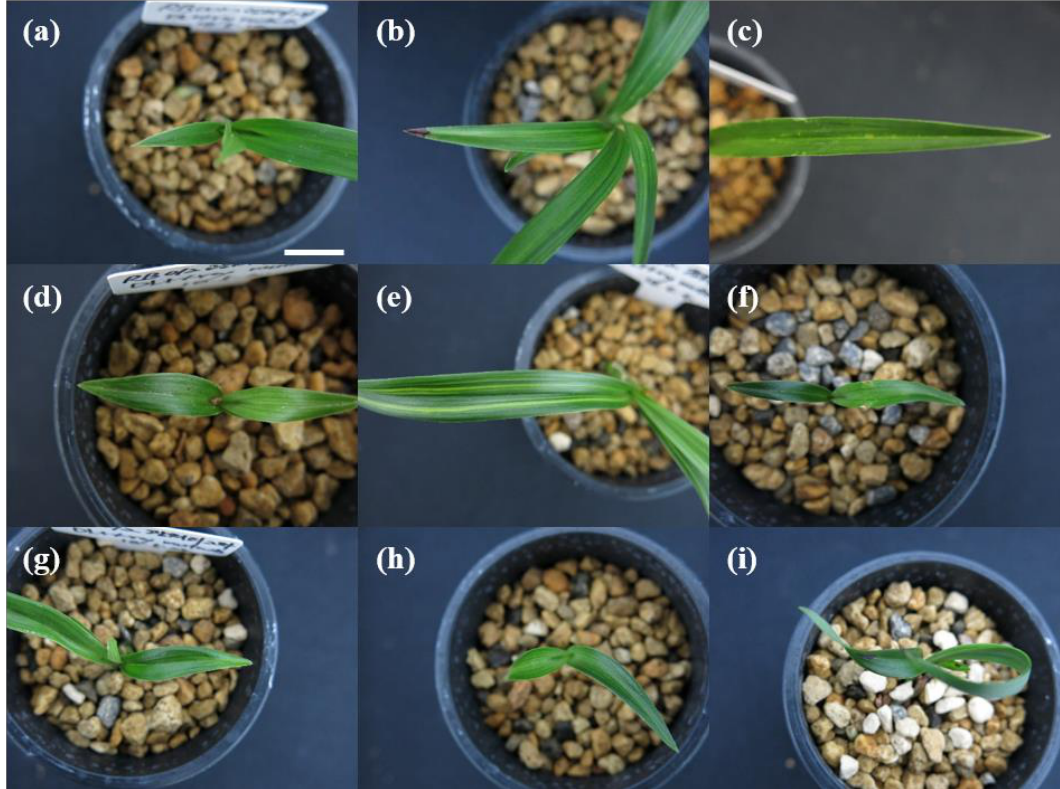
Figure 5. Representative leaf-color and -shape mutants induced by dark/light treatments followed by γ-irradiation in Cymbidium hybrids RB003 and RB012. ( a – c ) Mutants induced in Cymbidium hybrid RB003; ( d – i ) Mutants induced in Cymbidium hybrid RB012. ( a , c ) Yellow marginal leaf-color mutants; ( b , d , e , g , h ) Yellow stripe leaf-color mutants; ( f ) Dwarf leaf-shape mutant; ( i ) Abnormal leaf-shape mutant. Scale bar: 1 cm.